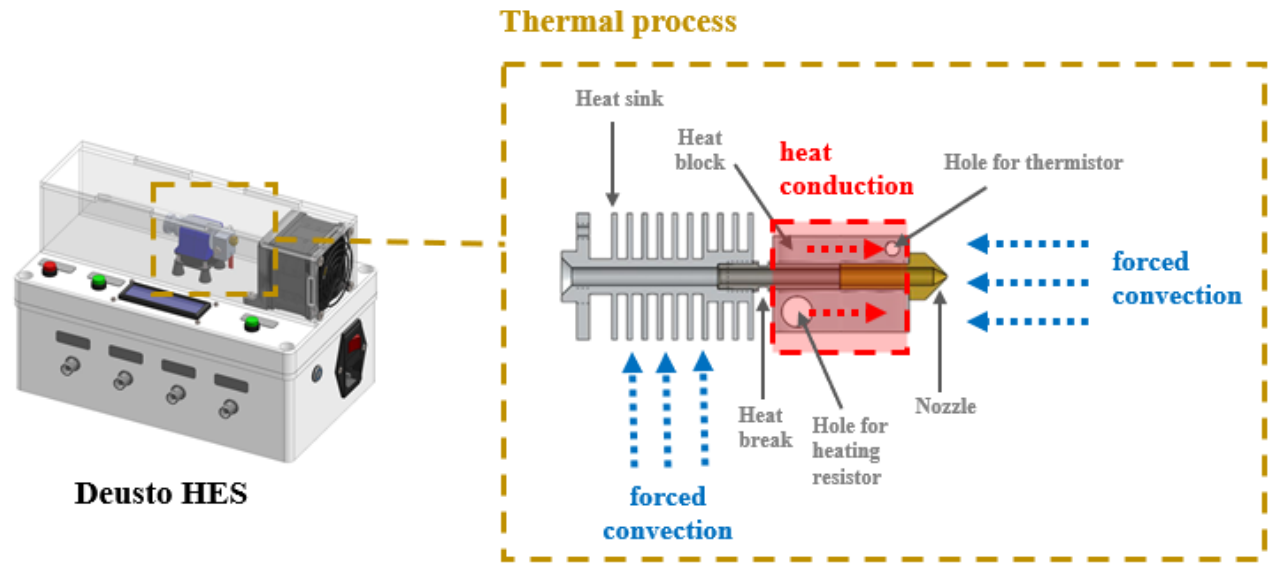
Figure 25. Deusto Heater Experimental Setup — 3D-model layout of the prototype and schematic detail of the thermal process.